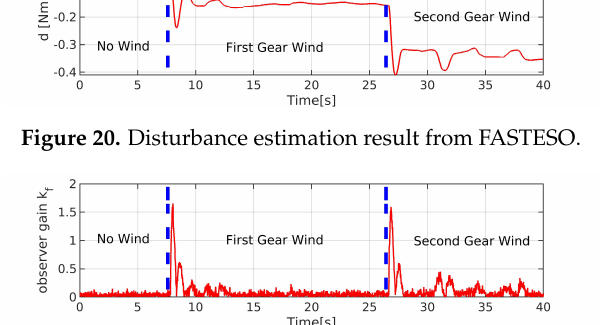
Figure 21. Observer gain of FASTESO during adaptation process.